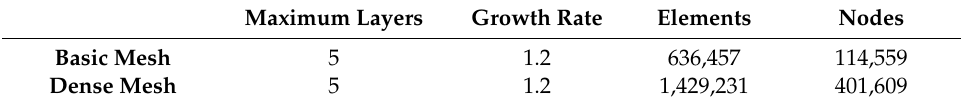
Figure 4. Meshing of manipulator section. Table 1. Parameters of basic and dense mesh.